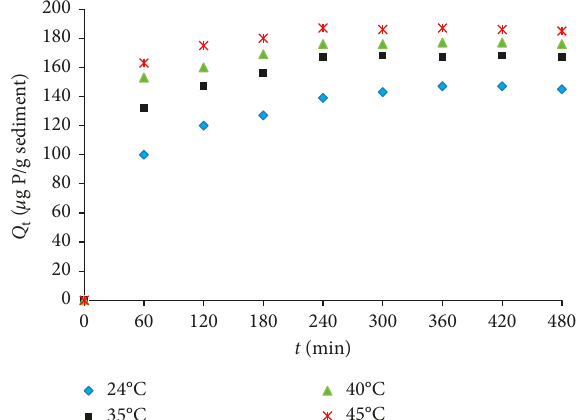
Figure 6: Kinetics of adsorption of phosphorus on Oued Bou- fekrane sediments at different temperatures, pH � 9.6, V int � 25ml, and phosphorus concentration � 5mg/L.